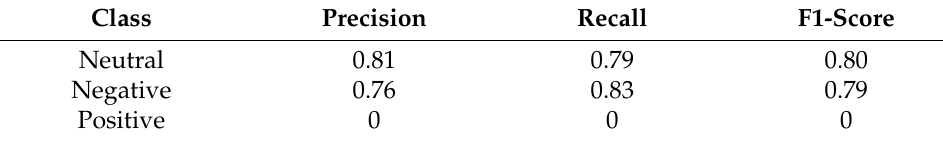
Table A3. Support Vector Machine evaluation.